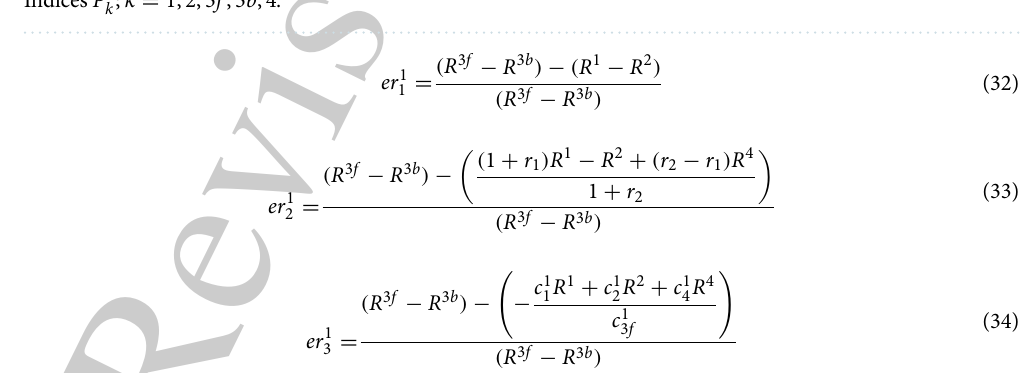
n k = 1, 2, 3 f , 3 b , 4 . BOTTOM: Amplitude Participation k ;